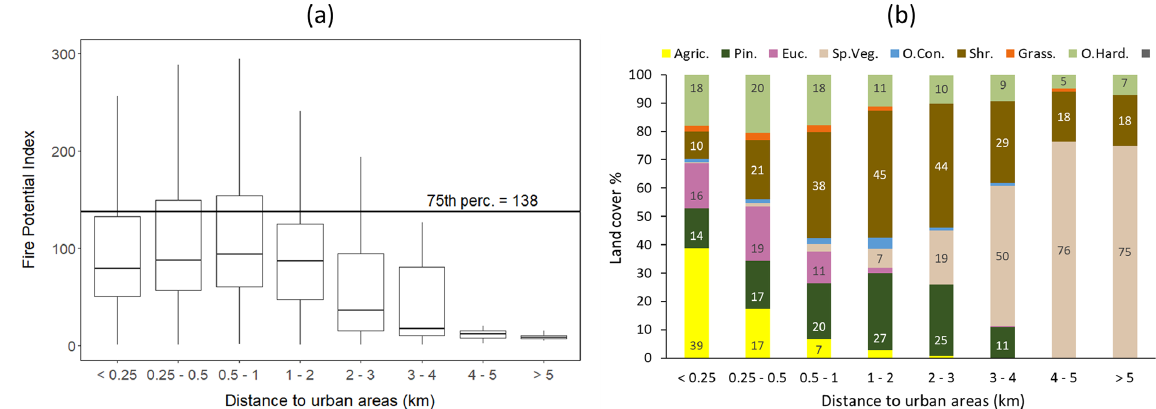
Figure 7. (a) Fire potential index (FPI) as a function of distance from urban areas and (b) main land cover percentages by distance from urban areas class. Only land cover classes that burned more than 5% are shown.